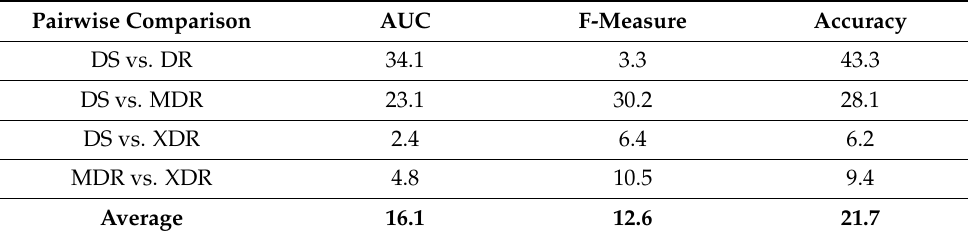
Table 4. Average difference between the proposed method and the previous methods mentioned in the literature (%).